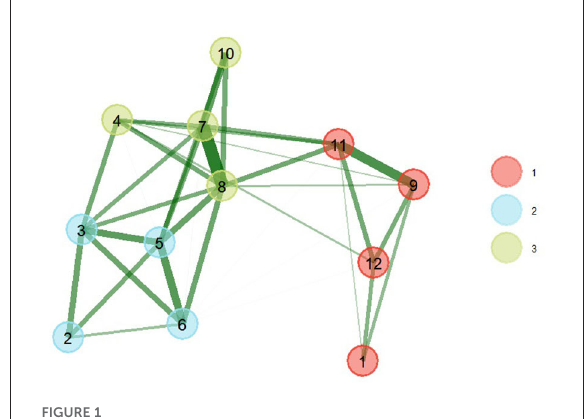
FIGURE1 EGA of comorbidity patterns with bootstrap (nboot = 200) (right). The greater the thickness of the connections, the greater the magnitude of the statistical relationships. The thickness of the line is equivalent to the magnitude of the ratio. (1) Arthritis, (2) Obesity, (3) Diabetes, (4) Kidney disease, (5) High blood pressure, (6) High blood cholesterol, (7) Heart attack, (8) Coronary heart disease, (9) Asthma, (10) Stroke, (11) Respiratory diseases, (12) Depression.